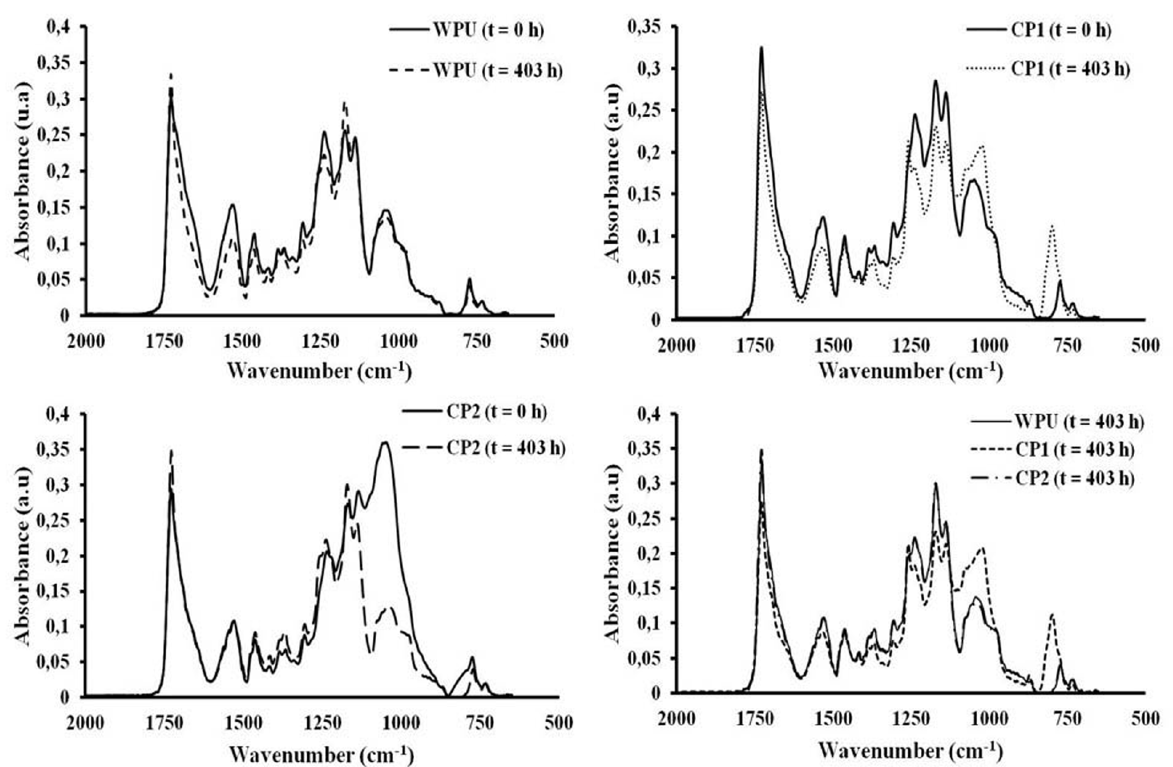
Figure 5 - FTIR spectra of the WPU and composites comparing before and after accelerated